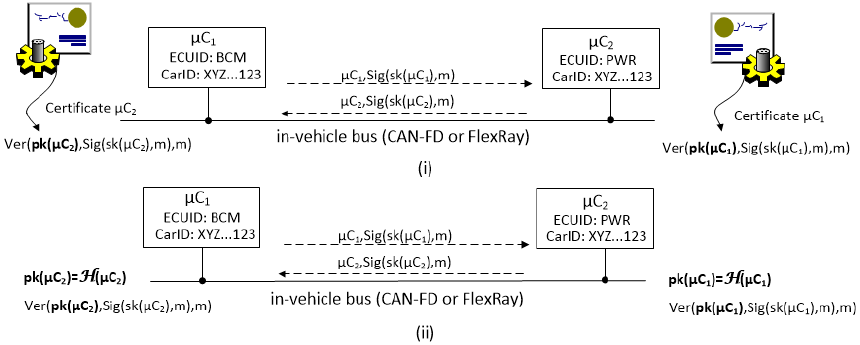
Figure 2. Exchanging signed messages in the conventional (PKI-based) setup ( i ) and in the identity-based setup ( ii